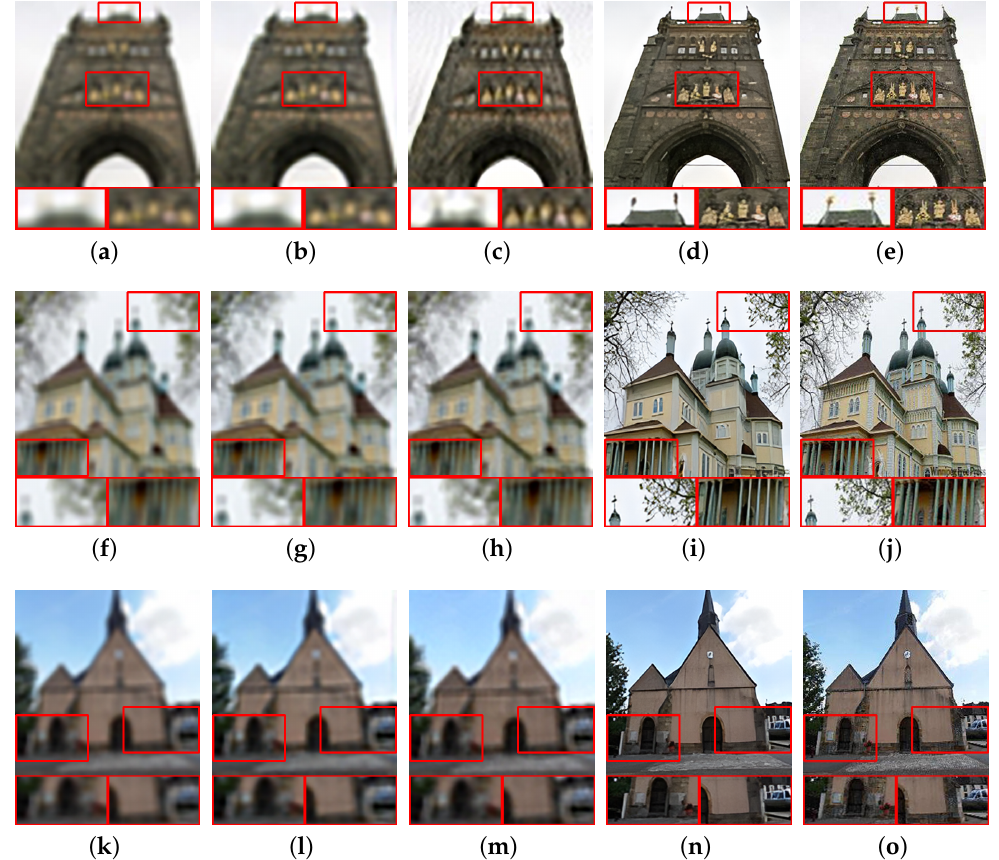
Figure 3. LSUN dataset test results. ( a ) Blur image; ( b ) DeblurGAN-v2; ( c ) Self-Deblur; ( d ) Ours; ( e ) Sharp image; ( f ) Blur image; ( g ) DeblurGAN-v2; ( h ) Self-Deblur; ( i ) Ours; ( j ) Sharp image; ( k ) Blur image; ( l ) DeblurGAN-v2; ( m ) Self-Deblur; ( n ) Ours; ( o ) Sharp